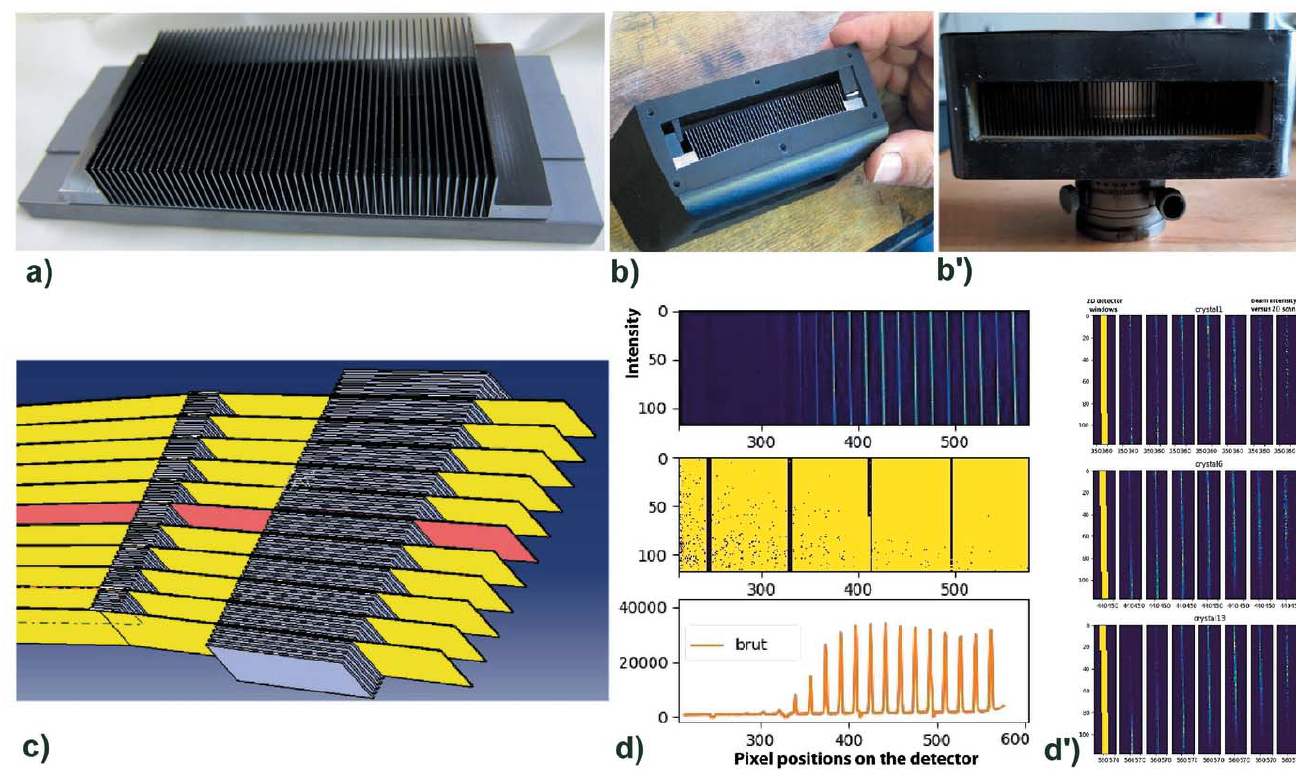
Figure 8 Single-crystal-comb MAD block having 50 Si(111) crystals working in reflection mode to filter powder diffraction patterns. ( a ) This silicon single-crystal- comb was cut to generate Si(111) planes 1.7 mm apart. Its single-crystal framework is perforated underneath and has a small thickness at the crystal junction (0.7 mm) to allow a few degrees of bending without generating stresses inside the Si(111) crystal blades. ( b ) Photograph of the single-crystal- comb block made by 3D printing that imposes the LogSpiral curvature to the silicon single-crystal-comb; it is mounted on the (cid:2) A arm of the diffractometer. ( b 0 ) Photograph of the 3D printed Soller-collimator block containing 51 collimator blades. It is mounted on the 2 (cid:2) A arm of the diffractometer after the single-crystal-comb block and before the 2D detector. ( c ) Scheme with 46 keV X-rays ( (cid:2) A = 2.4632 (cid:3) ) of 11 paths of the 50 beams (spaced by 0.1 (cid:3) ) and filtered by this rigid compact analyser block associated with the Soller-collimator block. ( d ) Example of intensities collected on the XPAD 2D detector during a 2 (cid:2) scan of the detector arm: they highlight the diffraction signal filtered by this single-crystal-comb with an angular pitch of 0.1 (cid:3) between each Si(111) crystal. ( d 0 ) Definition of the small reception windows on the detector for three analyser crystals (Nos. 1, 6, 13) with an example of the intensities collected with a 0.002 (cid:3)